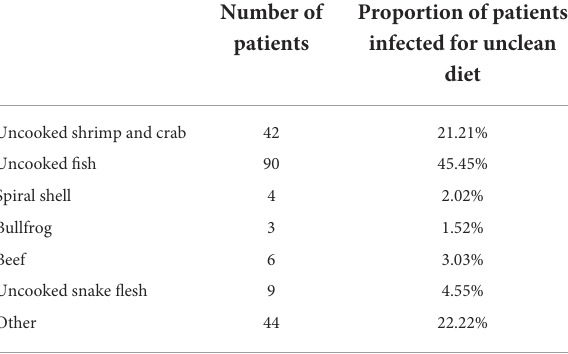
TABLE 4 Patients infected for unclean diets.